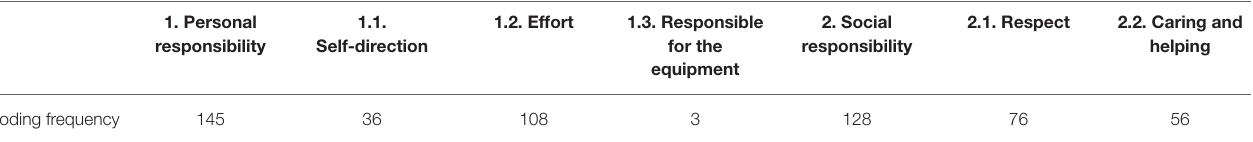
TABLE 5 | Interview coding